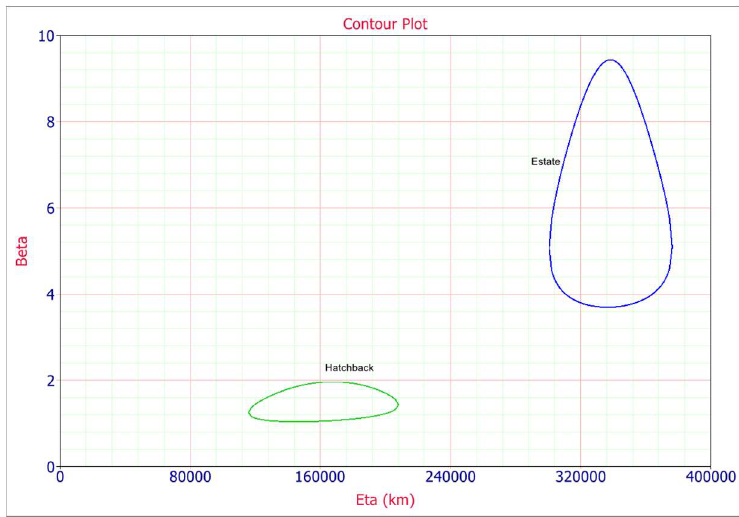
Figure 6. Contour plot at the 90% confidence level.